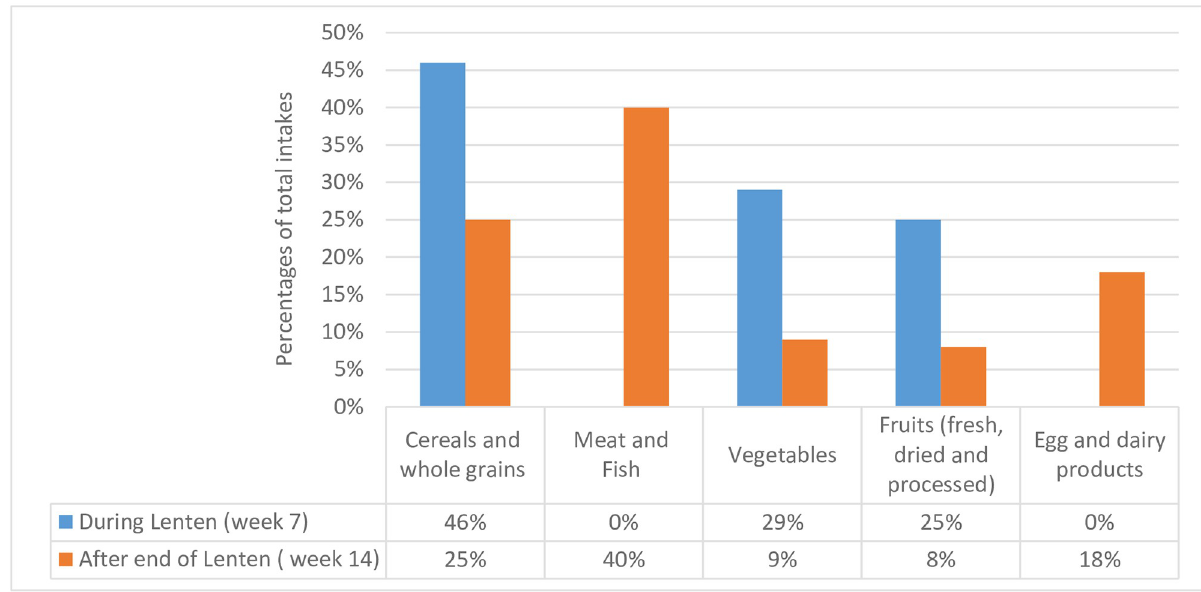
Fig 1. Percentages of animal and plant origin food intakes during and after the Lenten fasting.